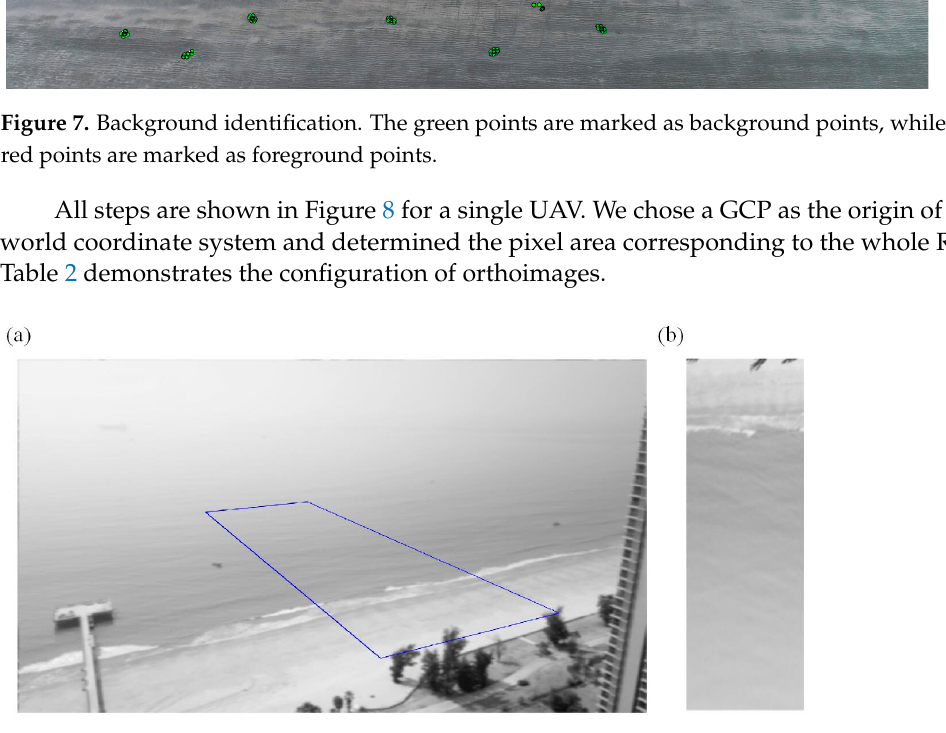
Figure 8. Schematic diagram of interest region selection. ( a ) The target area is shown in the blue line in the original scene image. ( b ) Unified pixel resolution orthoimage. Table 2. Configuration of orthoimages of a single video.